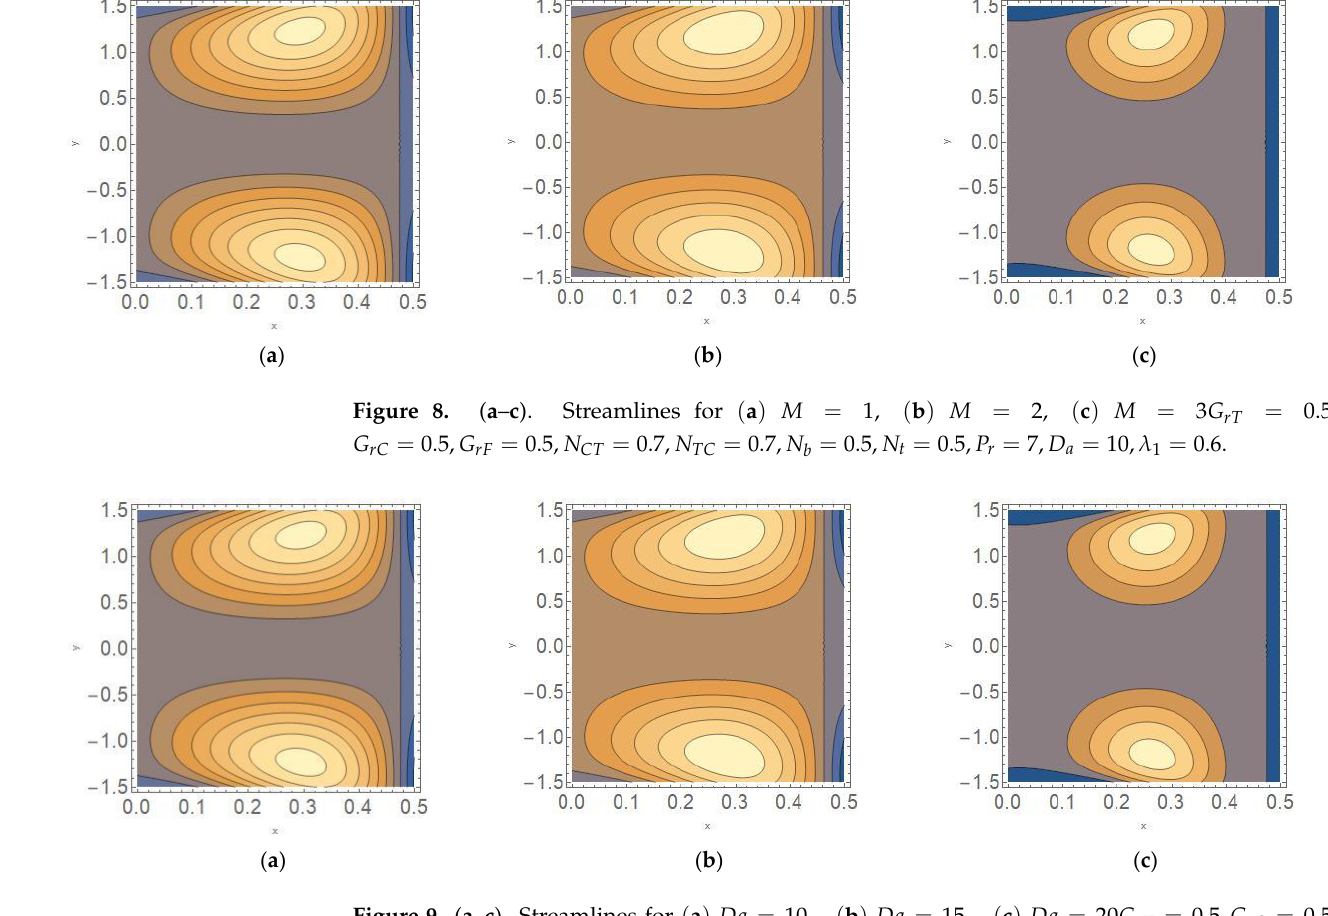
= 0.5, = 0.5, G rT rC